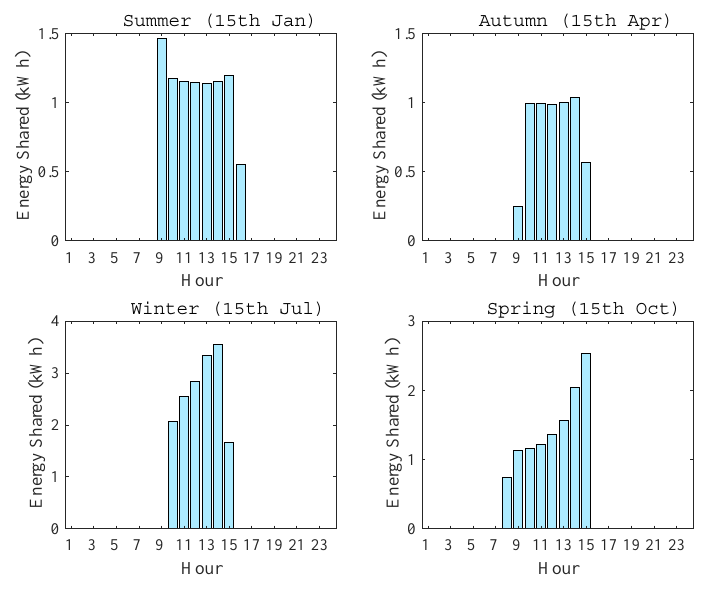
Figure 20. Energy sharing during a typical day in different seasons within the microgrid.